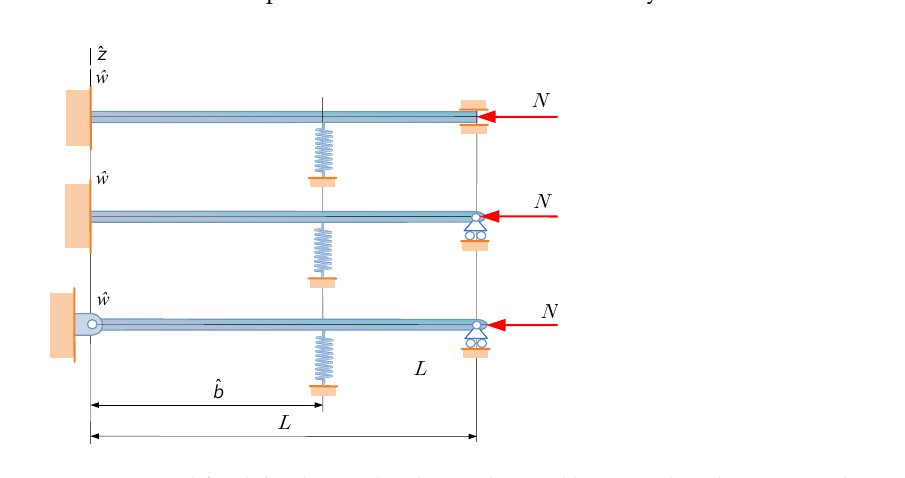
Figure 1. Fixed-fixed, fixed-pinned and pinned-pinned beams each with an intermediate spring support.